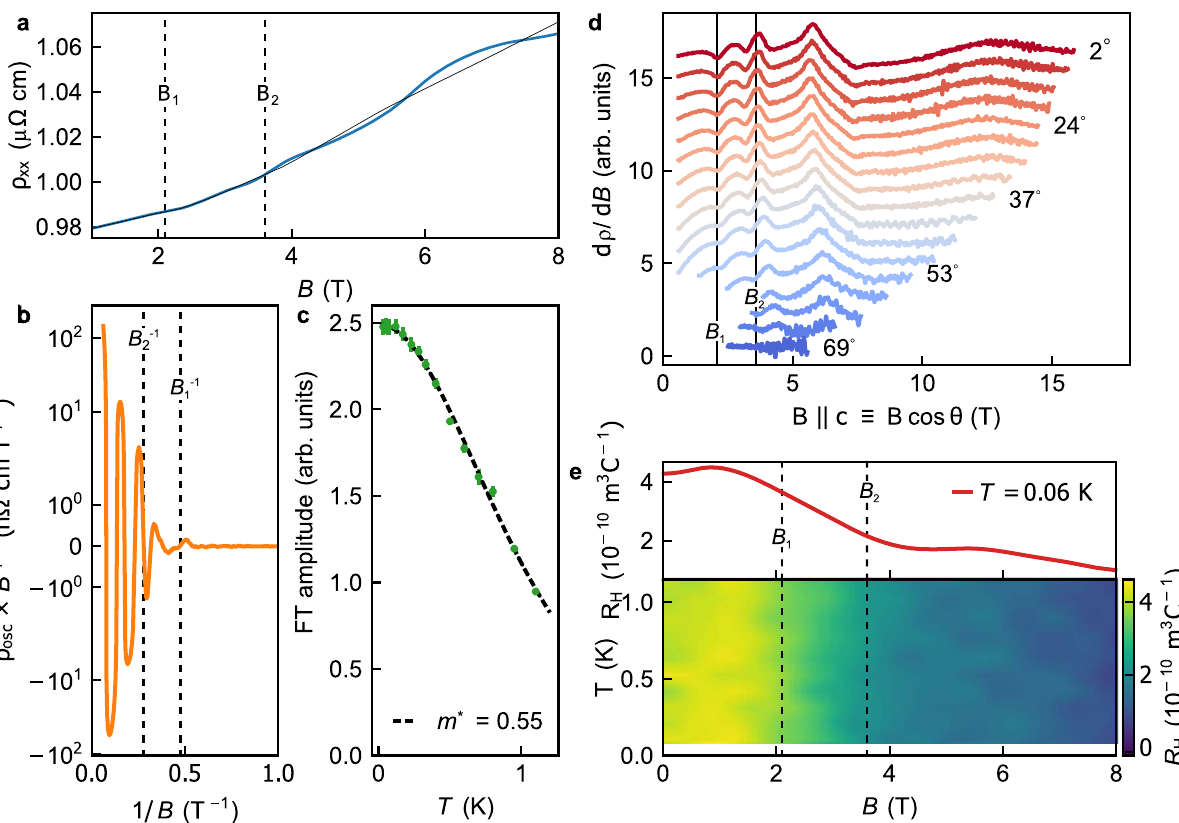
Fig. 3 Quantum oscillations and Hall effect in α -YbAlB 4 . a ρ , I ∥ c vs B ∥ c at T = 0.03 K, the overlaid black line is the non-oscillatory component, ρ MR that is subtracted. b The oscillatory component of resistivity; ρ osc × B 1/2 plotted on a double logarithmic scale (values < 10 − 3 are plotted on a linear scale). c Temperature dependence of the Fourier transform of ρ osc . d d ρ / dB against B ∥ c at various angles of B in the [001] → [110] plane where θ = 0 ≡ B ∥ [001]. e (Upper panel) Hall coef fi cient B ∥ c at T = 0.06 K. (Lower panel) surface plot of Hall coef fi cient against fi eld and